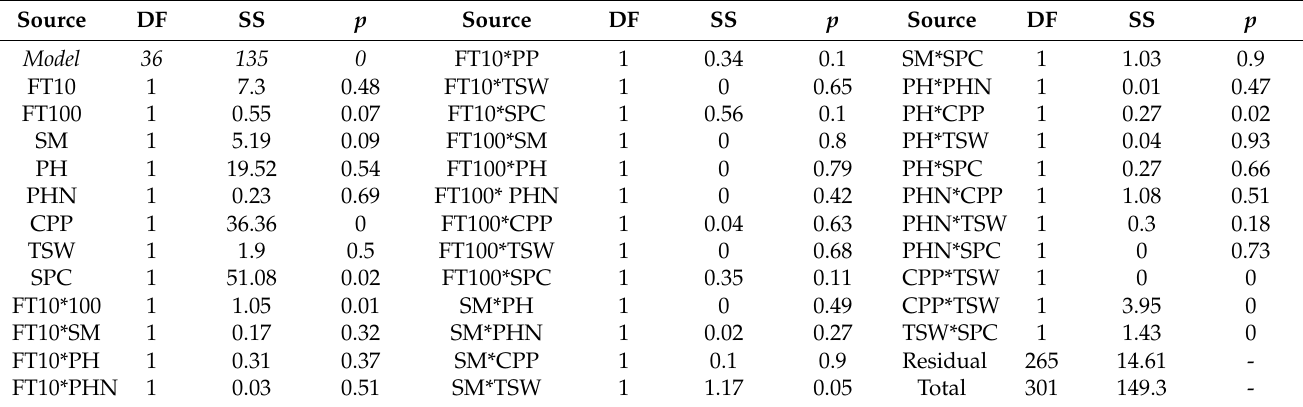
* Interaction function between the two independent variables; p -value ( p ); sum of squares (SS). The percentage contribution (PC) for the features applied for the estimations of the SSY is generated by dividing the sum of the squares of each feature by the total sum of the squares. Presented in Figure 5, the PC of error is 9.84% in the training step, with the CPP ( x 6 ) and SPC ( x 8 ) displaying the highest PC. As interaction factors such as x 12 (FT10*FT100) , x 16 (FT10*CPP), and x 67 (CPP*TSW) have the lowest PC, it can be assumed that the x 6 and x 8 variables are very effective parameters for SSY estimation. The FT10*SPC ( x 18 ), SM*TSW ( x 37 ), CPP*SPC ( x 68 ), and TSW*SPC ( x 78 ) interaction variables also contributed significantly to determining the SSY.